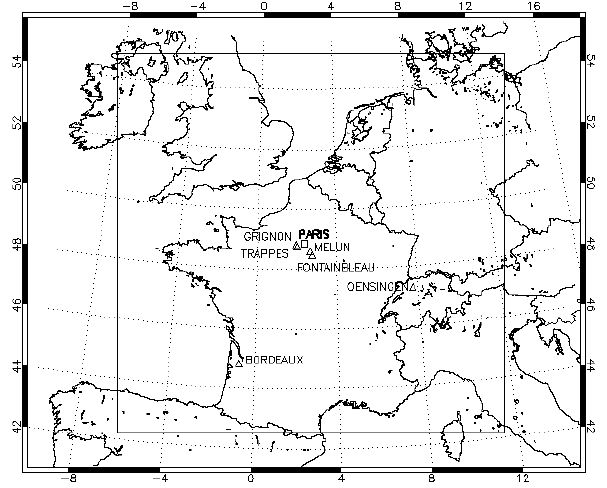
Fig. 1. Location of the model domain and the observational Figure 1: Location of the model domain and the observational stations. 3